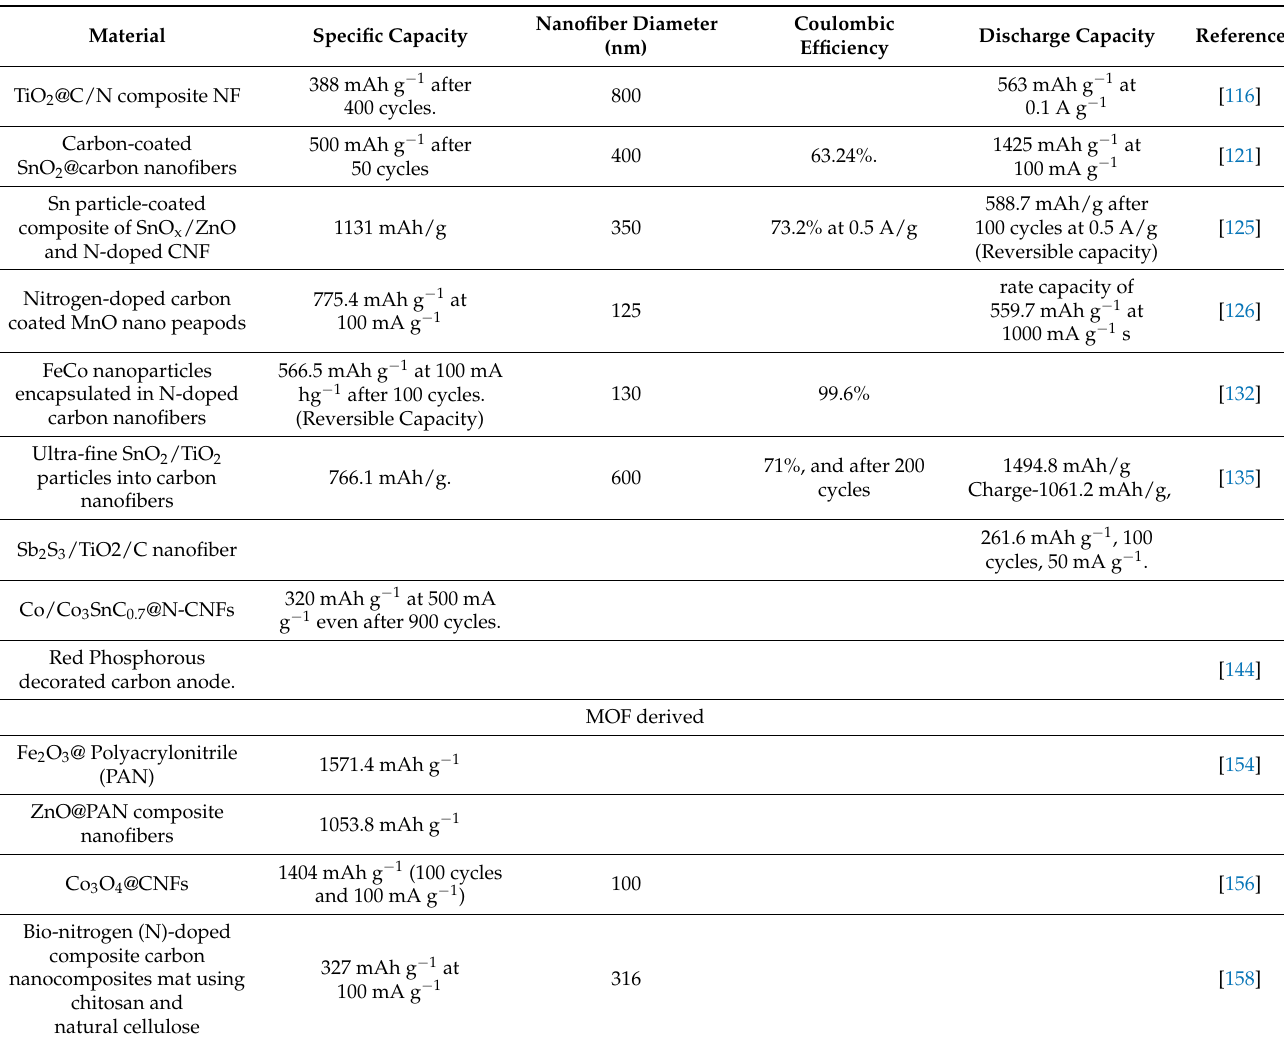
Table 4. Electrochemical properties of advanced anode